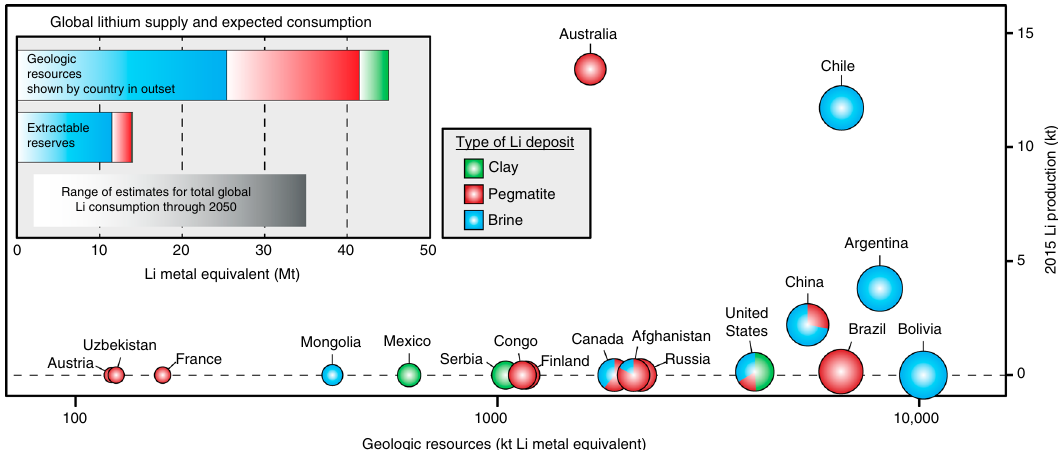
Fig. 1 Global lithium resources and total 2015 – 2050 estimated consumption. Estimates for global Li resources are ~45 Mt Li and include brine, pegmatite, and clay resources 7,10 . Global Li reserves (the amount of the resource that is currently economically extractable) are estimated at ~14 Mt Li, primarily from brine and clay deposits 7, 10 . Future Li consumption (2015 – 2050) estimates range anywhere from 3 – 35 Mt Li, depending on the ef fi ciency of Li extraction and projections for electri fi cation of the automobile industry 6, 8 – 10 , highlighting the need to explore for new resources of